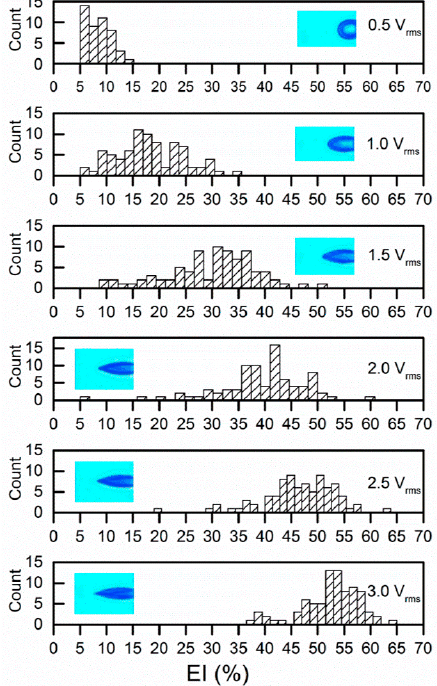
Figure 2. Electrodeformation EI values of red blood cells (RBCs) at a series of voltage levels with insets of representative deformed cells.